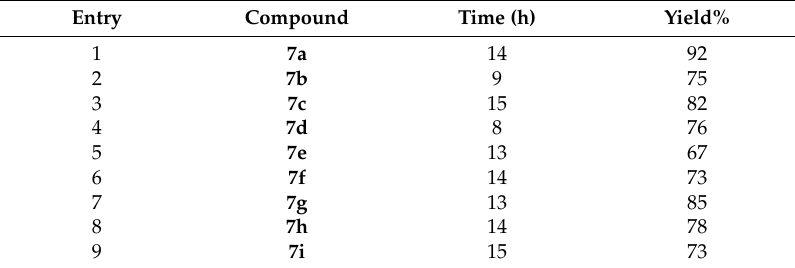
Table 1. Optimization in synthesis of chalcones 7a – i .